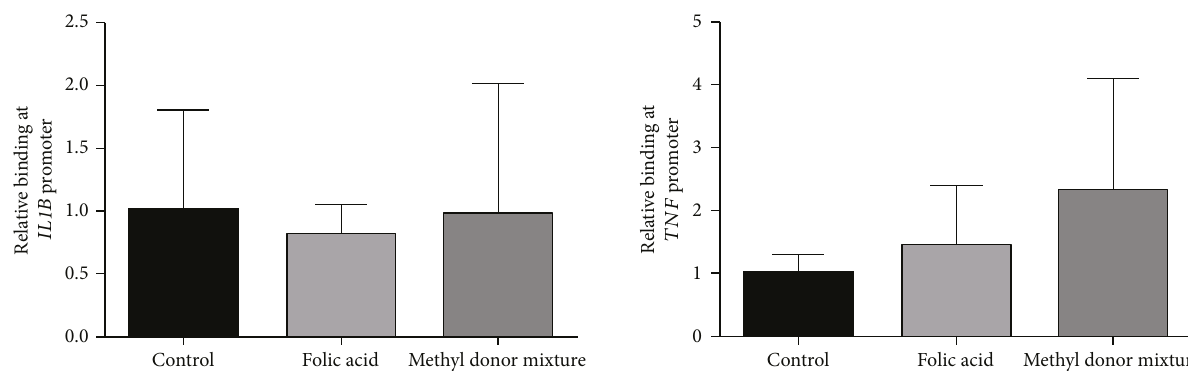
Figure 3: Relative binding of NF- κ B to IL1B and TNF promoters in THP-1 cells di ff erentiated with TPA and activated with LPS (control group) and the same cells treated with folic acid and the methyl donor mixture before di ff erentiation. Results are expressed as means ± SD ( n = 8 ). Di ff erences between groups were tested by one-way